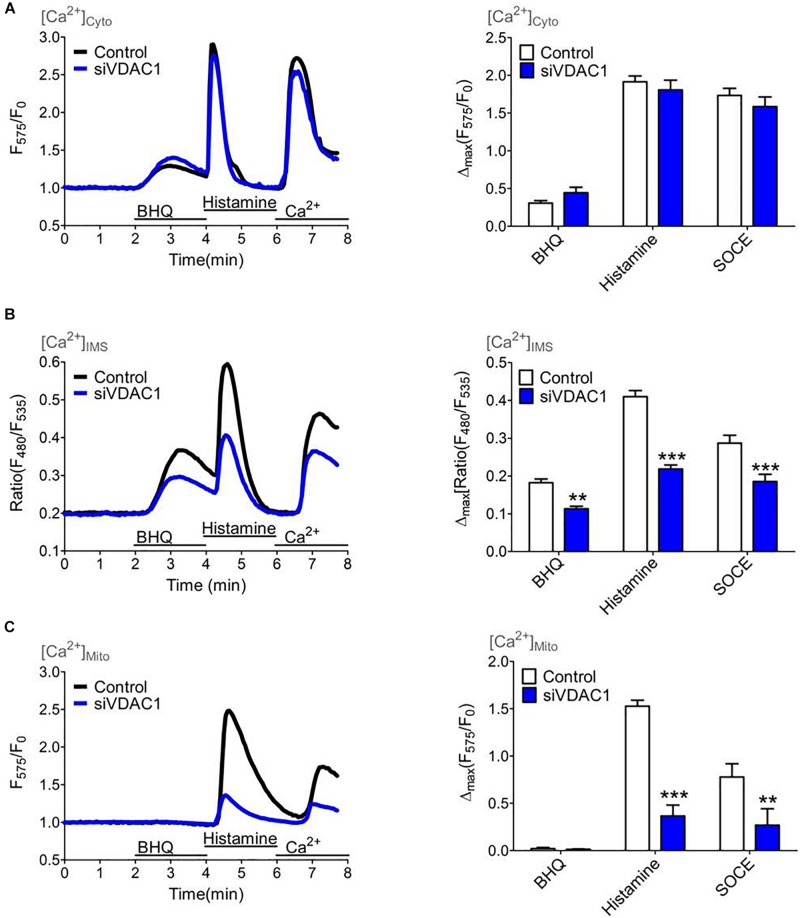
Mitochondrial (sub-)compartmental Ca2+ signaling upon knockdown of VDAC1 that controls the Ca2+ transfer through the outer mitochondrial membrane (OMM). HeLa cells were treated with either a siRNA against VDAC1 (siVDAC1, blue curves and bars) or a scrambled Control siRNA (Control, black curves and white bars) and Ca2+ imaging (A–C) was performed over time by consecutively application of 15 μM BHQ and 100 μM histamine in the absence of extracellular Ca2+ following a readdition of extracellular Ca2+ to highlight store-operated Ca2+ entry. (A) Average cytosolic Ca2+ curves (left panel) and statistical analysis for Control (n = 11) and for siVDAC1 (n = 11) of maximal Ca2+ elevations during treatment with either 15 μM BHQ, 100 μM histamine or re-addition of 2 mM Ca2+ (SOCE) (right panel). (B) Average curves of [Ca2+]IMS (left panel) and statistical evaluation of maximal Δ ratio signals (right panel) for Control (n = 19) versus siVDAC1 (n = 19). (C) Average curves reflecting mitochondrial Ca2+ signals (left panel) and bar graph (right panel) showing maximal normalized Δ intensities for Control (n = 17) and siVDAC1 (n = 10). ∗∗P < 0.01 and ∗∗∗P < 0.001 vs. Control.